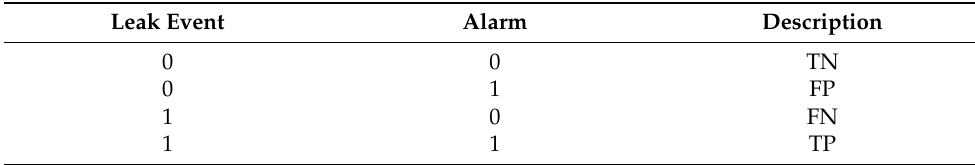
Table 4. Leak detection truth